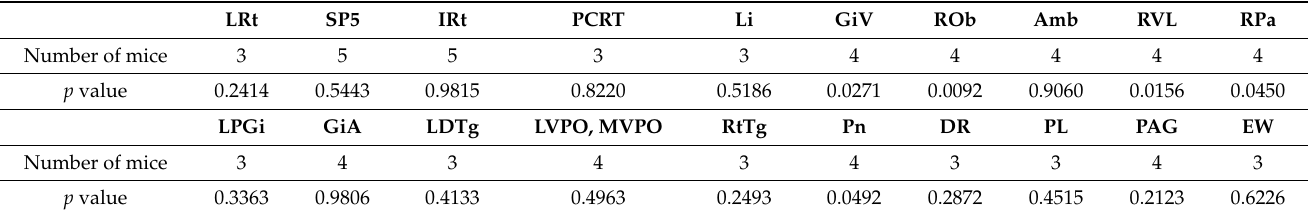
Table 1. c-Fos statistics of brainstem